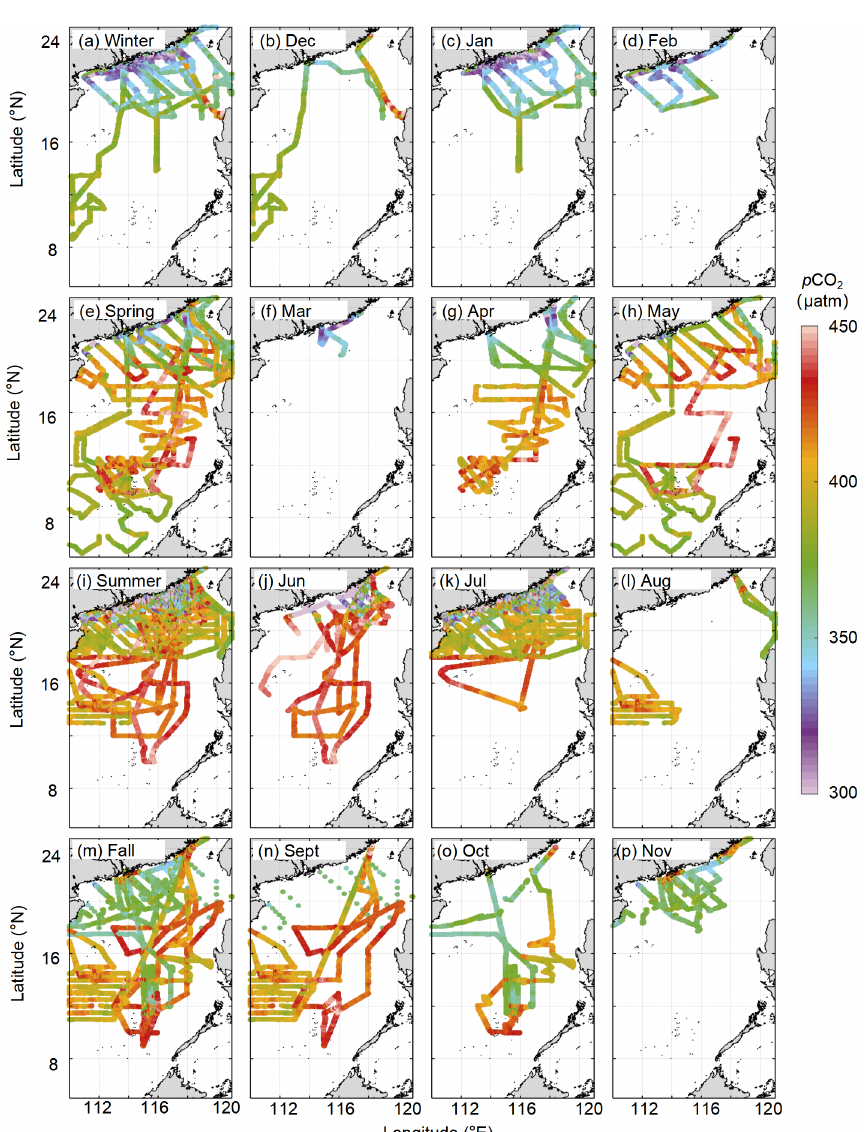
Figure 3. Seasonal and monthly sea surface p CO 2 fields in the South China Sea. (a) Winter. (b) December, (c) January. (d) February. (e) Spring. (f) March. (g) April. (h) May. (i) Summer. (j) June. (k) July. (l) August. (m) Fall. (n) September. (o) October. (p) November. The data sources are given in Table